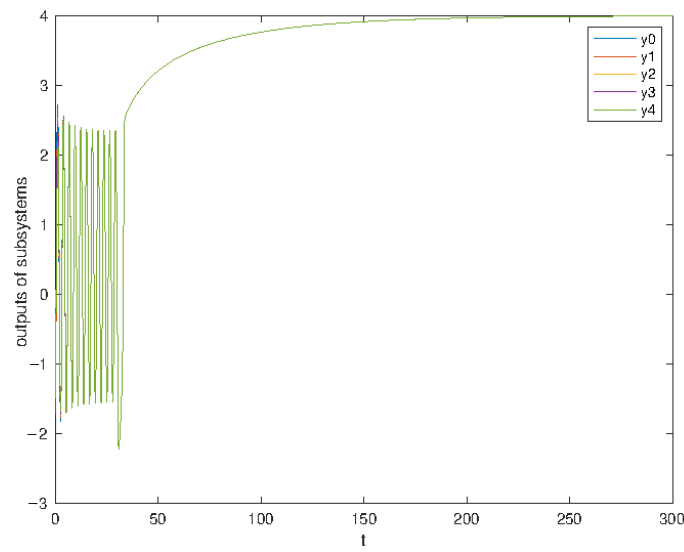
Figure 1. The subsystem outputs y i , i = 0, . . .